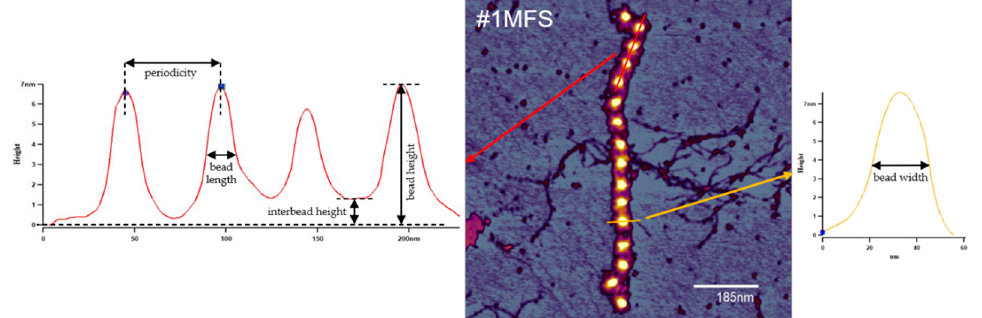
Figure 5. Schematic representation of the sections used for measuring the structural parameters of fibrillin-1 microfibrils. Considering the arbitrary disposition of the microfibrillar assemblies, bead length (longitudinal section, red) and width (transversal section, yellow) were assessed in respect to the median axis of the respective micro fi bril.